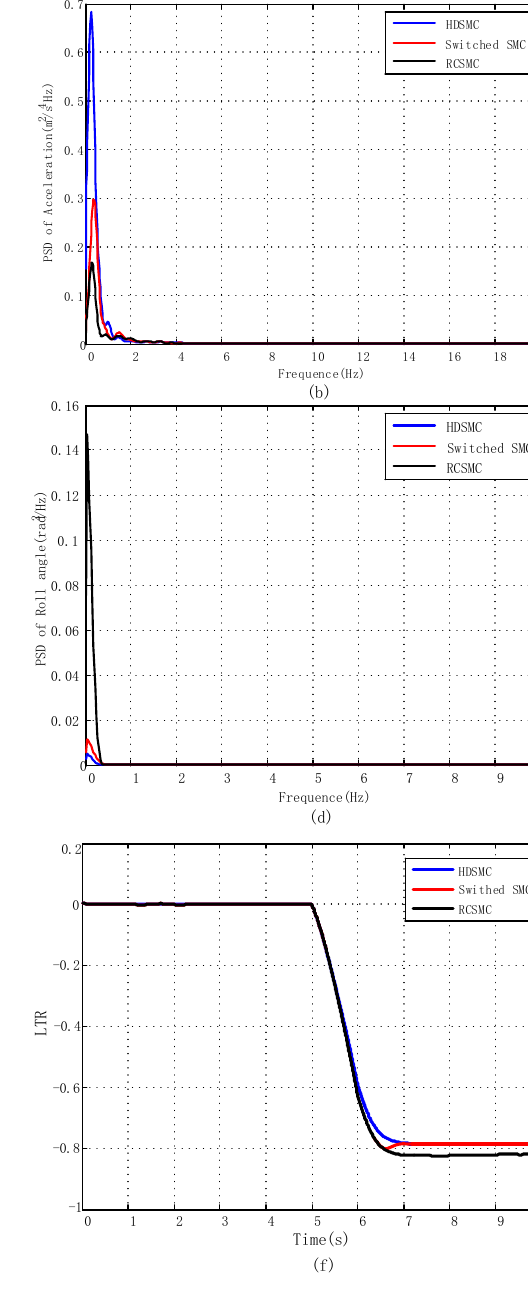
Figure 14. The rescue vehicle dynamic response based on the switch strategy under the random road and the J-turn maneuver: ( a ) the vehicle body vertical acceleration in time domain; ( b ) the roll angle acceleration in time domain; ( c ) the vehicle body vertical acceleration in time domain and in frequency domain; ( d ) the roll angle acceleration in frequency domain; ( e ) the switch value; ( f ) the load transfer ratio (LTR).